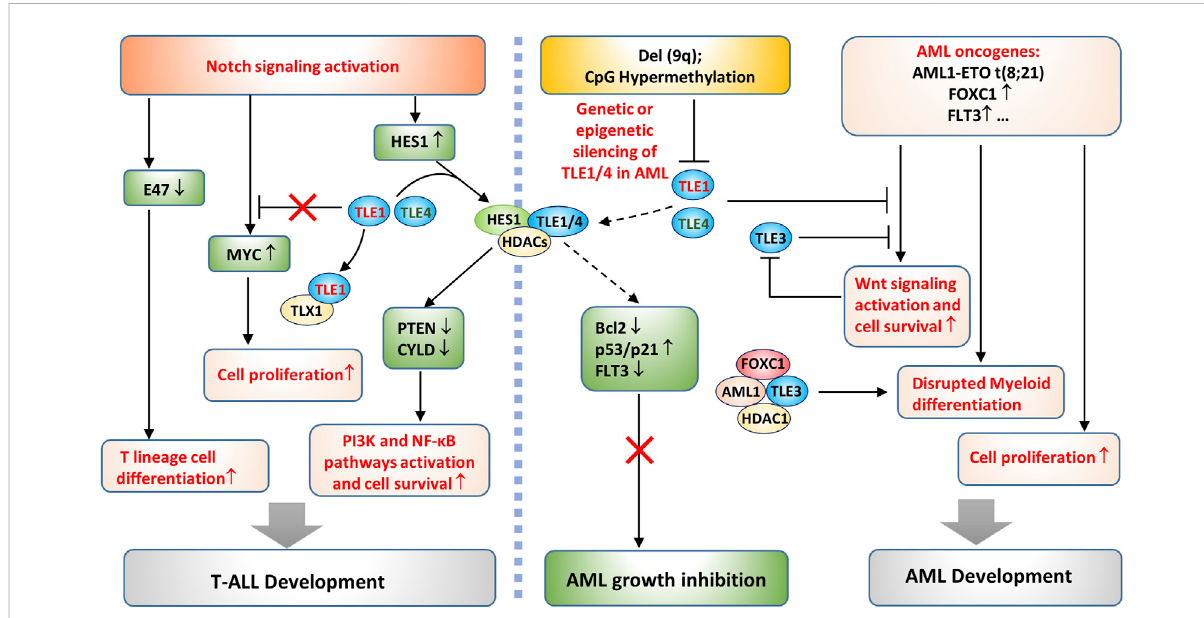
FIGURE 6 TLE-regulated pathways in AML and T-ALL development. On the one hand , deletion of aportion of the long arm of chromosome 9, del (9q), or CpG island hypermethylation in the TLE1 promoter causes genetic or epigenetic silencing of TLE1 and TLE4 in AML cells. The loss of TLE1/ TLE4 disrupts the TLE/HES1/HDAC complex, which otherwise inhibits AML growth by increasing p53/p21 and decreasing Bcl-2 expression (Kannan et al., 2013). Loss of HES1/TLEs may also promote AML growth by derepressing FLT3 expression (Kato et al., 2015) and enhancing Wnt signaling activation. On the other hand, AML oncogenic events promote cell proliferation and disrupt the terminal differentiation of myeloid cells, both of which are required for AML development. Notch activation promotes T-ALL development by several means. It directly upregulates the Notch target geneMYCtopromotetumorcellsurvival.NotchactivationinhibitsE47,whichleadstocommittedTlineagedifferentiationofT-ALLcells.Inaddition, Notch activates HES1 expression and suppresses the expression of PTEN and CYLD, thereby enhancing PI3K and NF- κ B pathway activation and cell